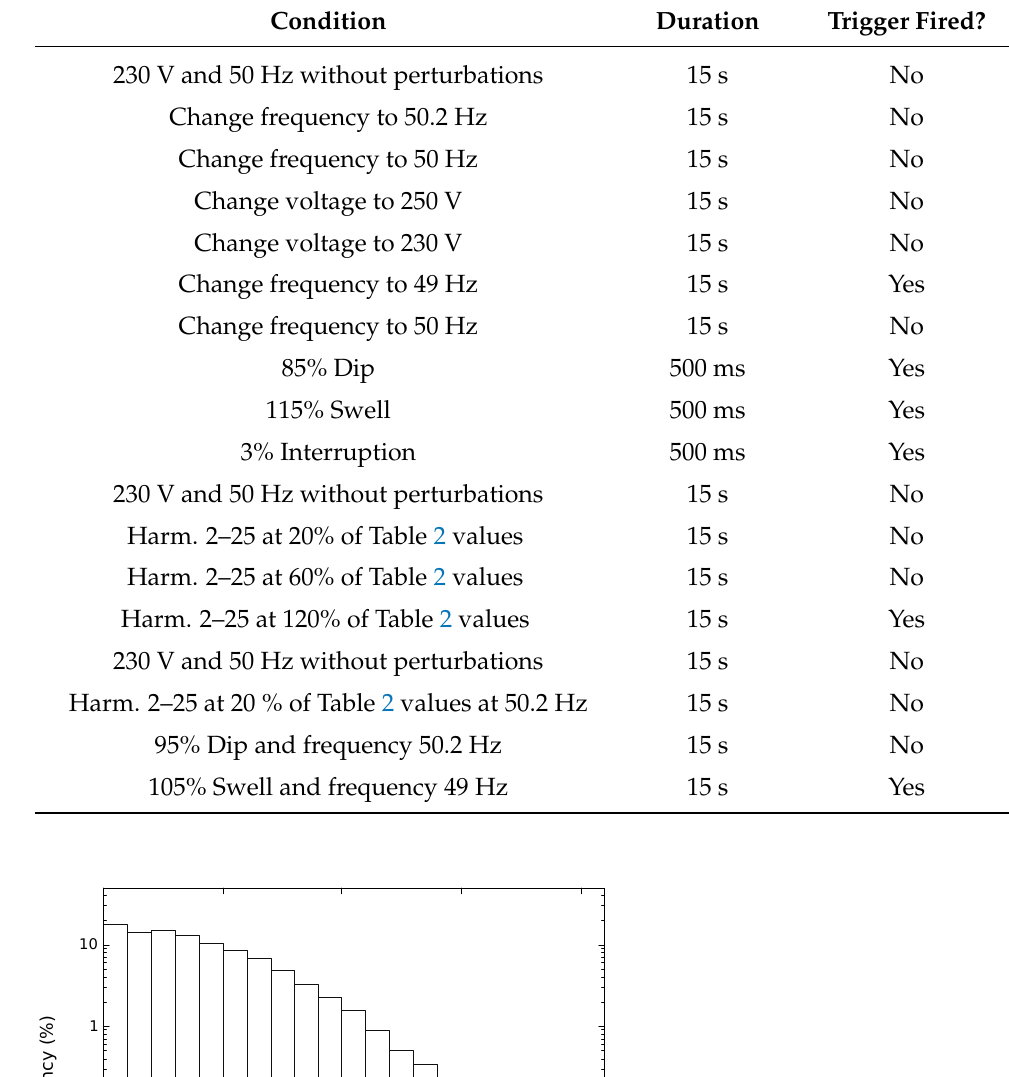
Table 3. Sequence of conditions used to test the AC PQ-based triggers.